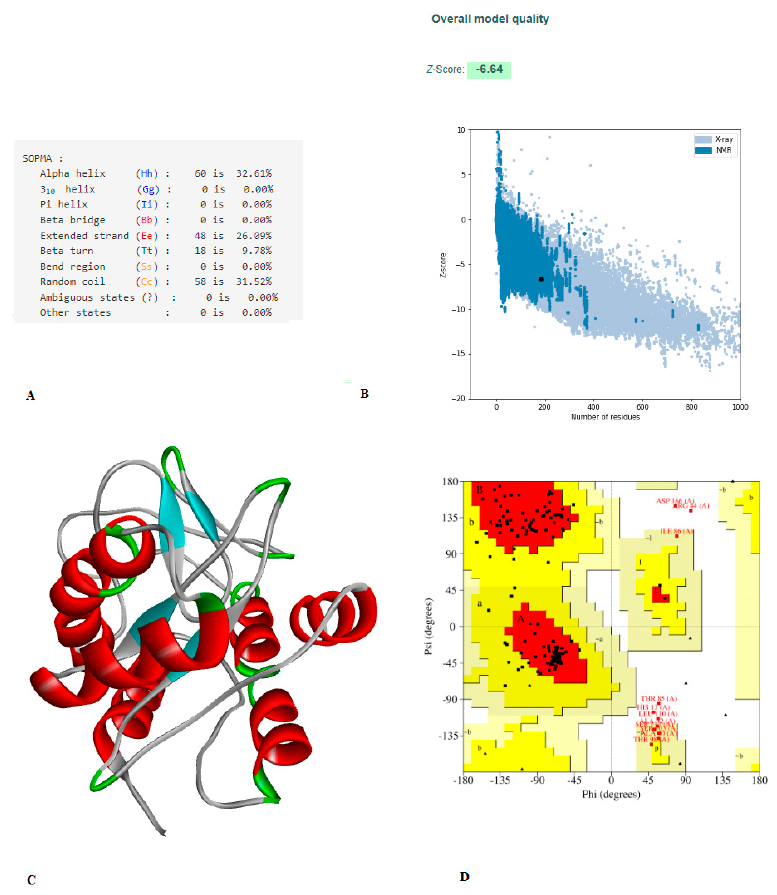
Figure 3. ( A ) The vaccine’s secondary structural characteristics. ( B ) 3D structure validation of with Z-scores is − 6.64, evaluated by Pro-SA server. ( C ) 3D model of structured vaccine. ( D ) Using the PROCHECK server, an analysis of the Ramachandran plot revealed that 80.7%, 12.7%, 3.0%, and 3.6% of the residues were found in the favored, additionally allowed, allowed, and disallowed,